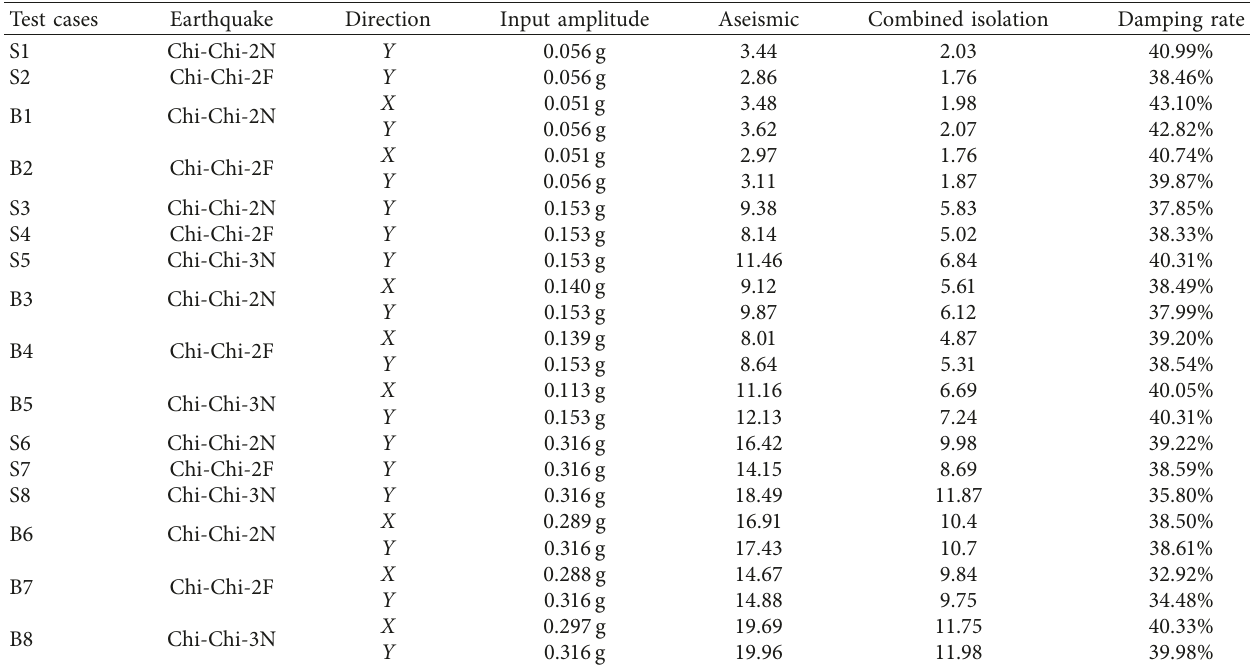
Figure 10: Y -axis relative displacement time history curves of the third floor of main frame. (a) Chi-Chi-2N, (b) Chi-Chi-2F, and (c) Chi- Chi-3N. Table 8: Main frame base shear response and damping rate